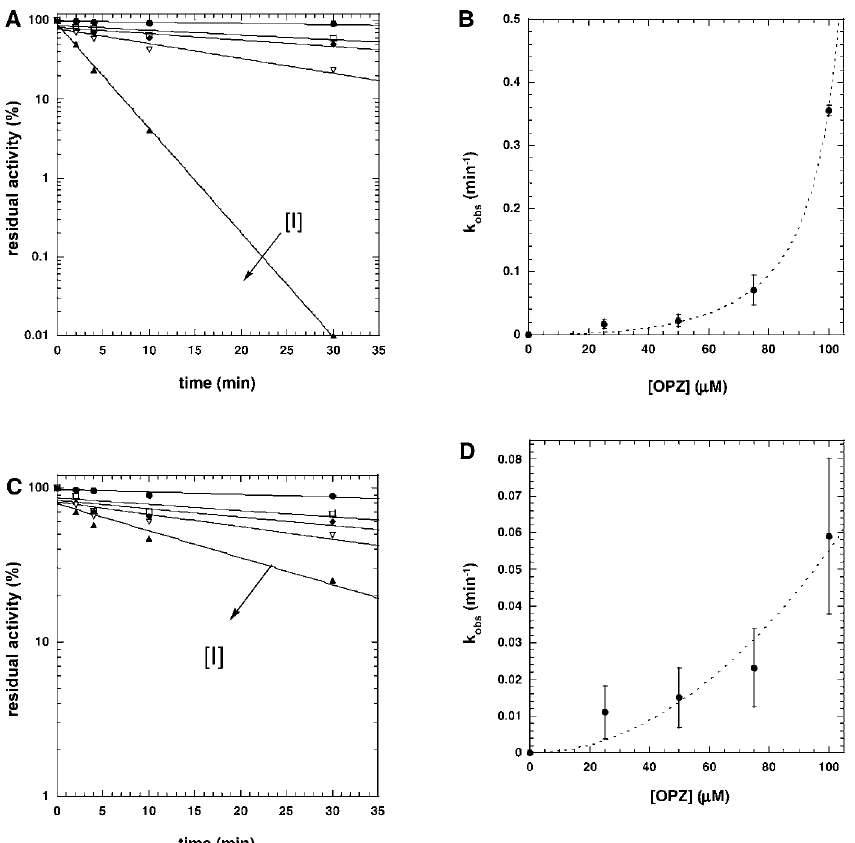
Figure 4. Time-Dependent Inactivation of S. mansoni TGR by OPZ The time dependency of inactivation of S . mansoni TGR (15 pmol/ l l) was revealed by determining the residual GR (A) and TrxR (C) activities of enzyme in the presence of 100 l M NADPH and inhibitor at 0, 2, 4, 10, and 30 min incubation periods. OPZ concentrations were 0 ( (cid:5) ), 25 ( & ), 50 ( ¤ ), 75 ( D ), and 100 ( m ) l M. All incubation mixtures included 2% final DMSO. The k obs data as a function of inhibitor concentration from the GR (B) or TrxR assay (D) versus OPZ concentrations followed a polynomial equation (not shown), suggesting that more than one binding site of OPZ is involved in the presence of different enzyme species of reacted and unreacted enzymes in mixture during the course of the inactivation process. The error bars in (B) and (D) represent 6 the standard errors of the k obs values estimated separately at each inhibitor concentration, as obtained from nonlinear regression